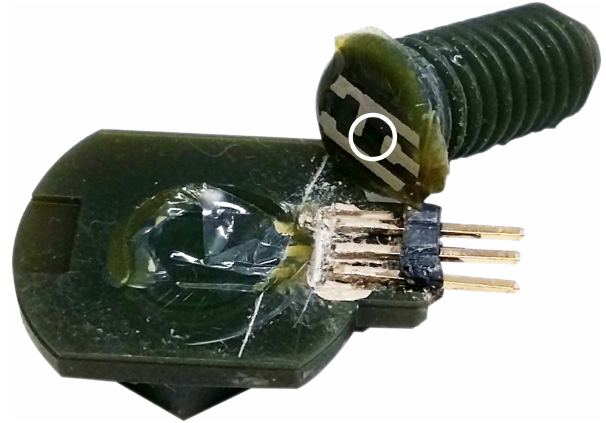
Figure 11. HTM140 M screw sheared off at the position of the sensor. The strain sensing resistor is marked with a white